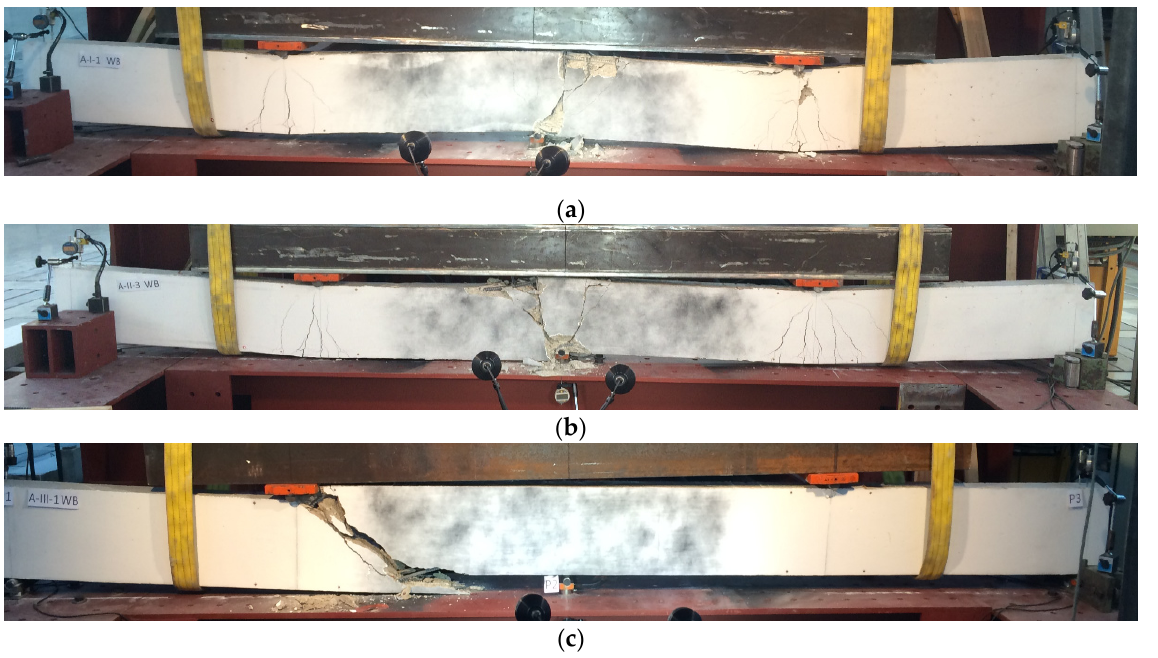
Figure 6. Failure modes for tested beams in series ( a ) C-I-WB5; ( b ) C-II-WB5; ( c ) C-III-WB5.